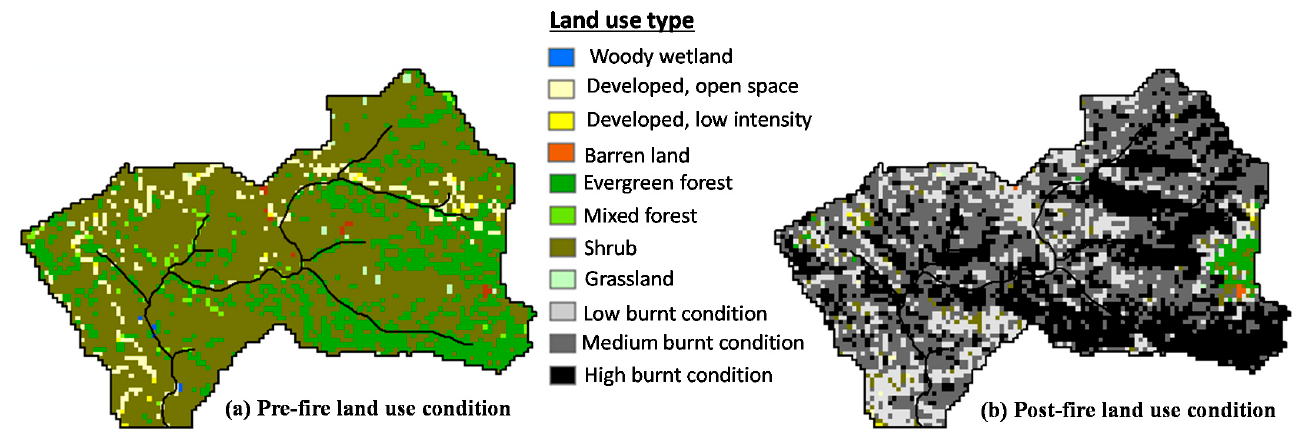
Figure 6. Pre- and post-fire land cover condition in the upper Arroyo Seco watershed.